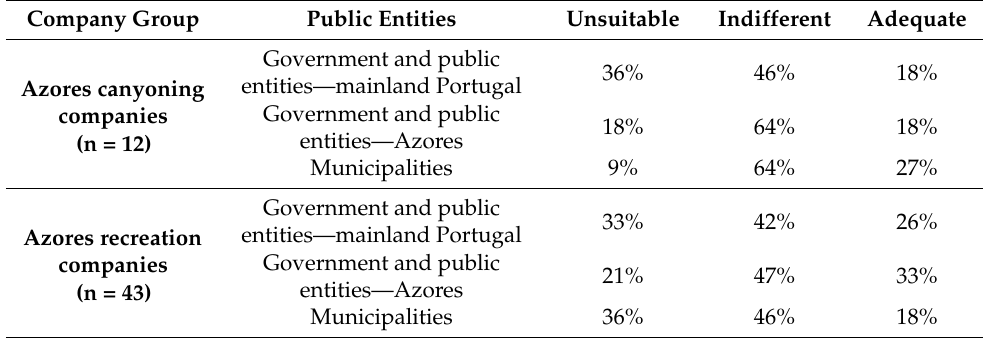
Table 5. Satisfaction with public entities’